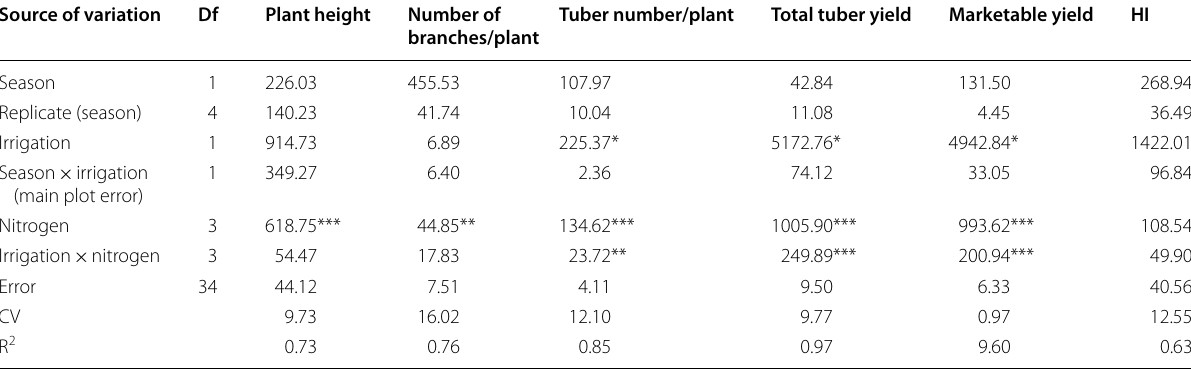
HI Harvest Index, ’***’, ’**’ and ’*’ are significance codes at 0.001, 0.01 and 0.05, respectively =